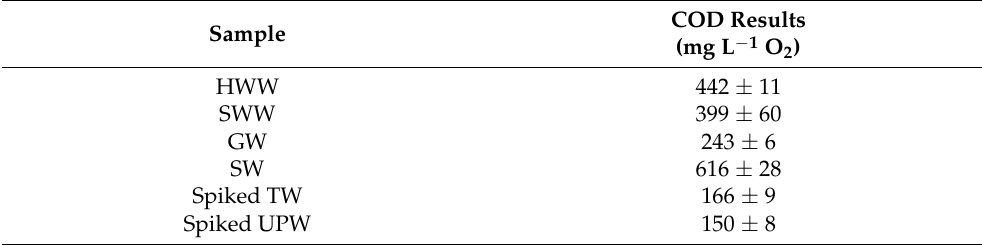
Table 2. Results of analyses using the standard colorimetric method and the miniaturized PhotoMetrix PRO method for determination of COD in various environmental aqueous matrices, showing the deviation between the